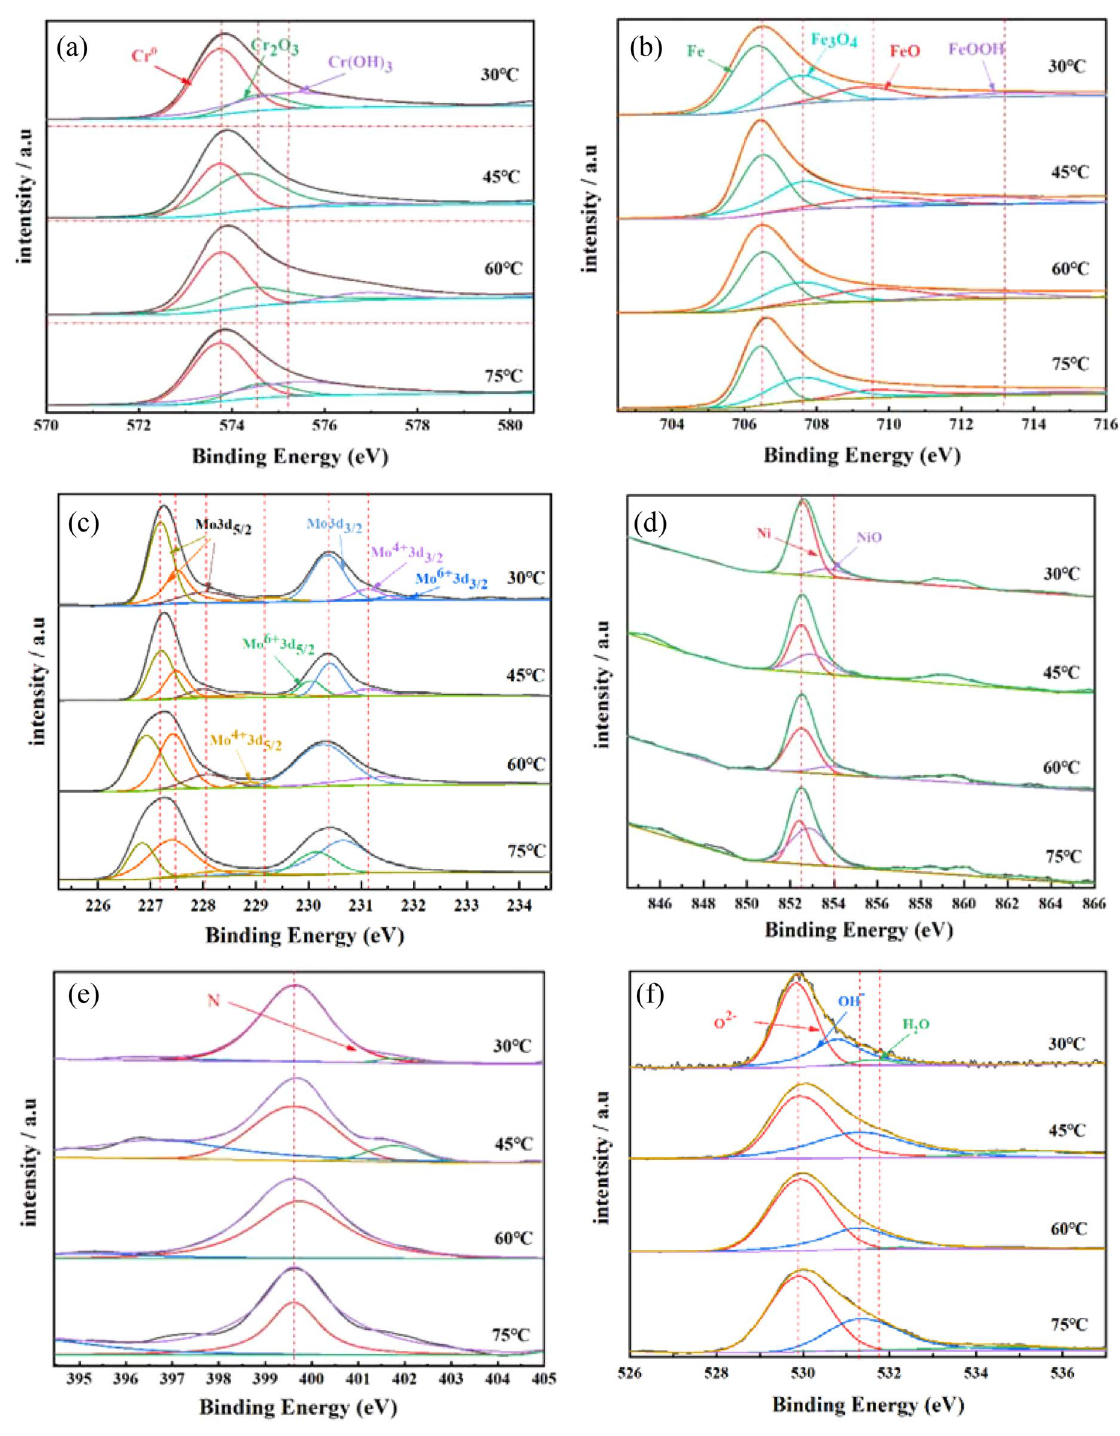
Figure 8. 2205 DSS at different temperatures; ( a ) Cr2p, ( b ) Fe2p, ( c ) Mo3d, ( d ) Ni2p, ( e ) N1s, ( f )